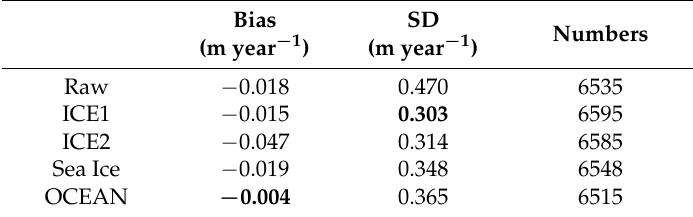
Table 1. Summary of the differences in the crossovers of descending and ascending orbits from SARAL. For each of waveform retracking algorithm, the bias and SD (standard deviation) of differences in the crossovers are given. The minimum values are highlighted in bold.